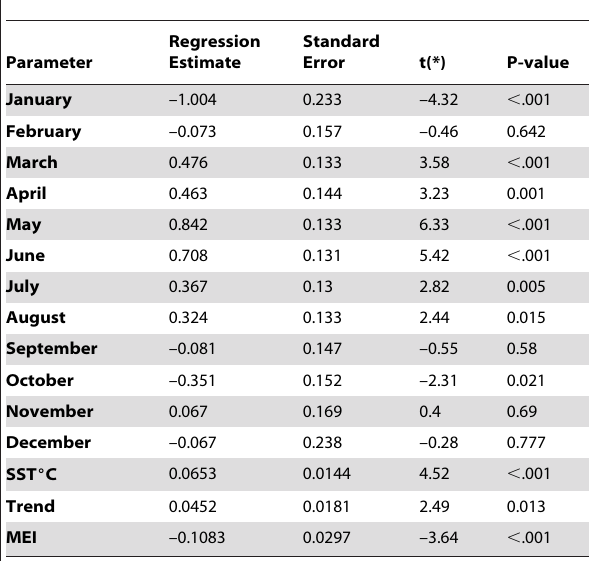
Table 5. Results of a generalized linear model relating total number of male great white sharks observed per trip in Gansbaai to specified explanatory